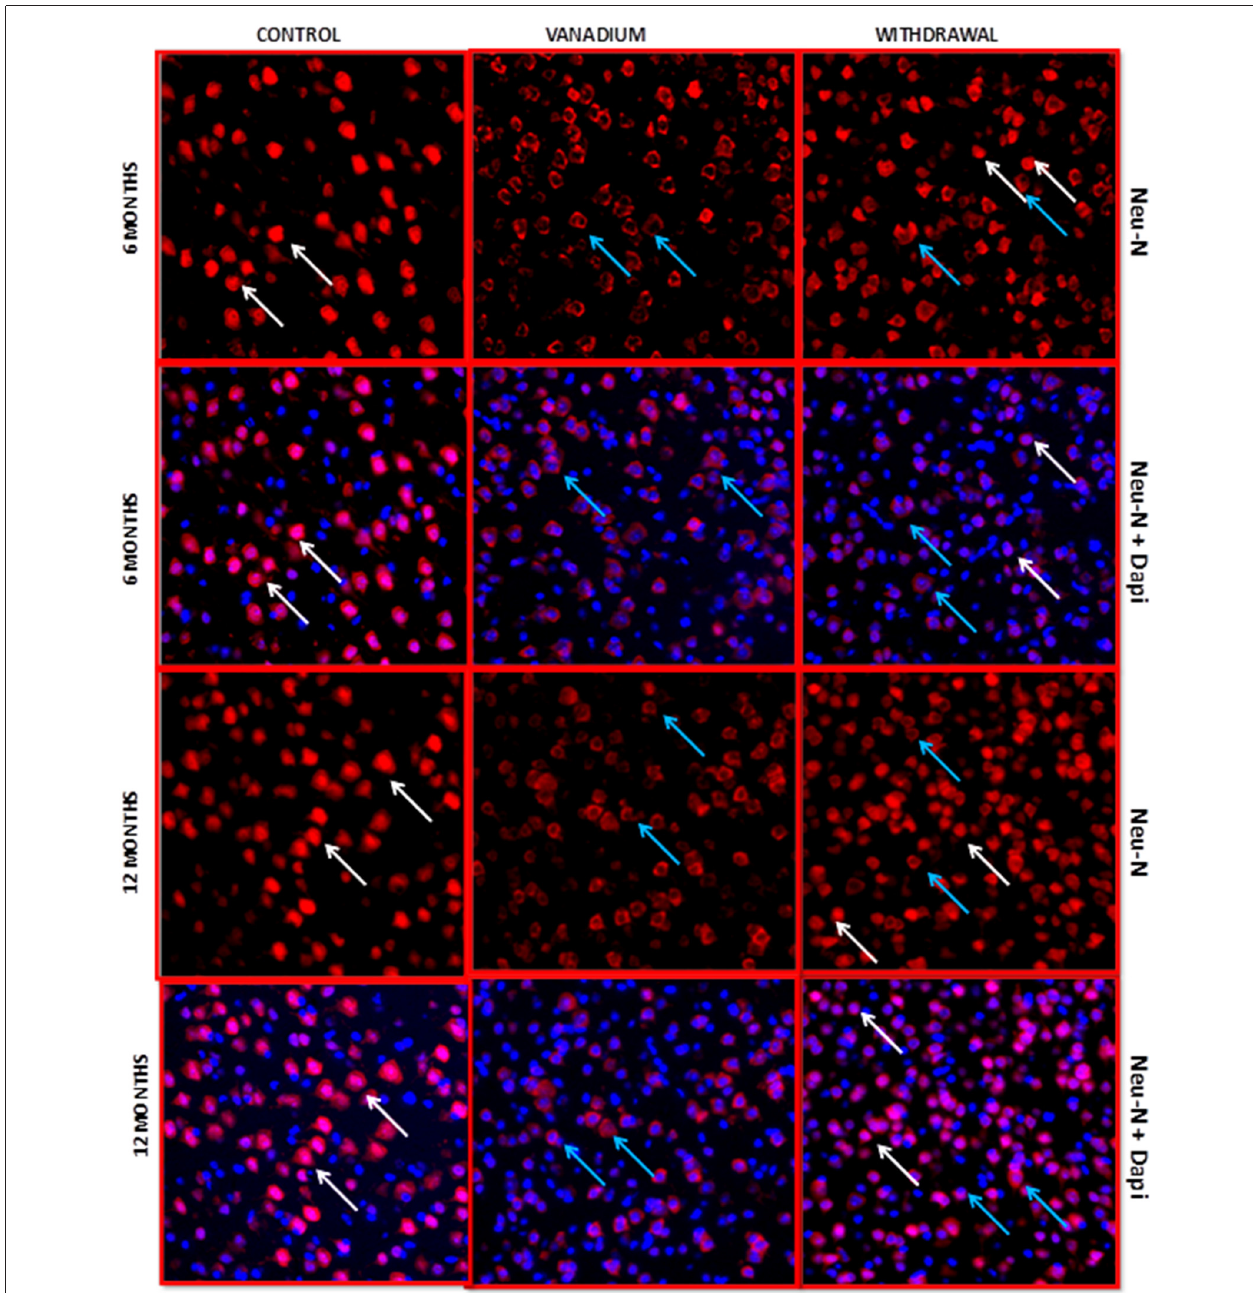
FIGURE 8 | NeuN + 4 (cid:48) ,6-diamidine-2 (cid:48) -pheynylindole dihydrochloride (DAPI) Immuno-fluorescent labeling of the prefrontal cortex revealed the fate of the nucleus after chronic vanadium exposure. NeuN colocalization with Dapi revealed pyramidal cells with intact but shrunken nucleus and cytoplasmic loss (blue arrows) relative to the control groups with normal morphology (white arrows), chronic vanadium exposure resulted in cytotoxicity which appear more pronounced than its apoptotic effects. Sections were double-labeled with NeuN antibody in conjunction with DAPI (blue), a nuclear DNA cell marker, and imaged at × 20 magnifications using confocal microscopy. Magnification: ×